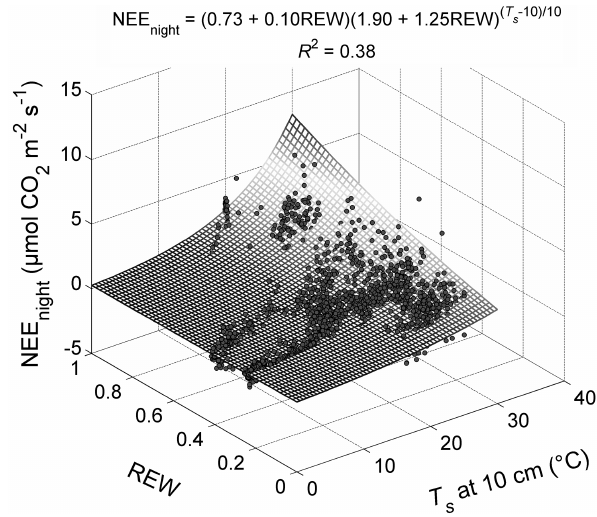
Figure 6. Nighttime net ecosystem CO 2 exchange (NEE night ) as a function of soil temperature ( T s ) at 10cm depth and relative ex- tractable water content (REW, see Eq. 10). Only data when T s >0 ◦ C were